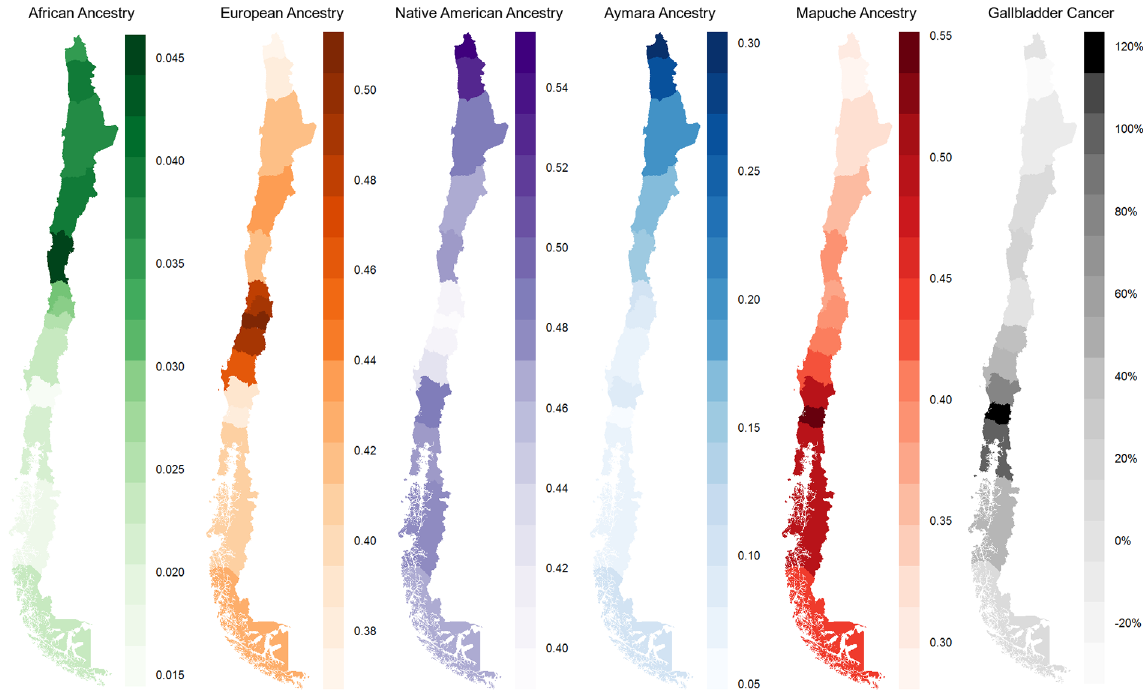
Fig 2. Maps with averageregional African, European, Native American, Aymara and Mapuche proportions, and regional mortality rates due to gallbladder cancer in Chile.